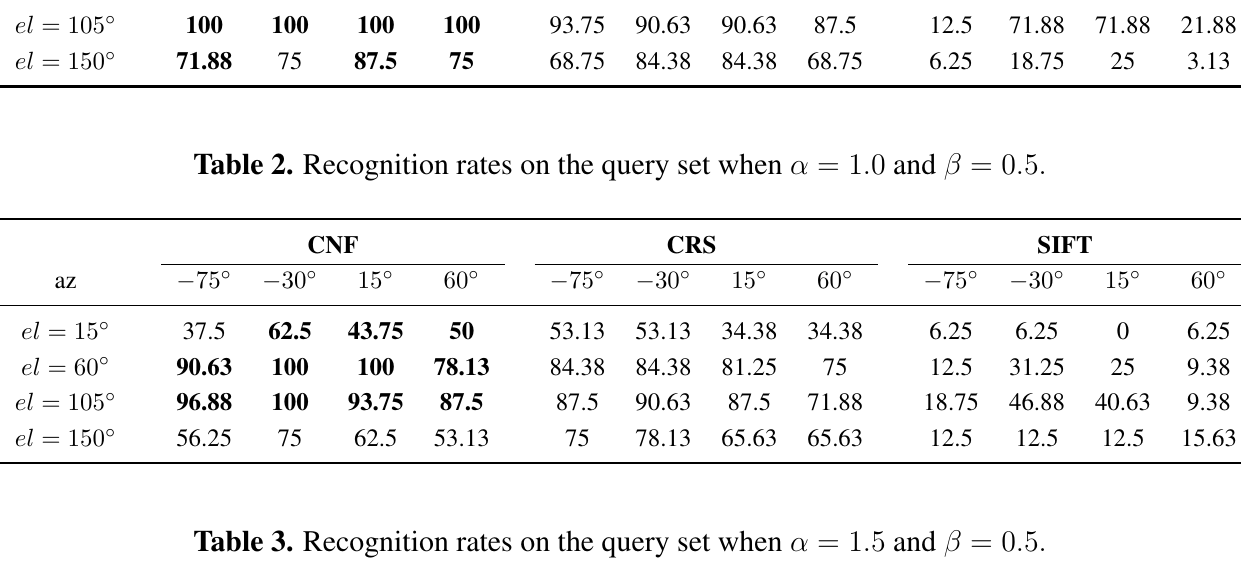
Table 3. Recognition rates on the query set when α = 1 . 5 and β = 0 . 5